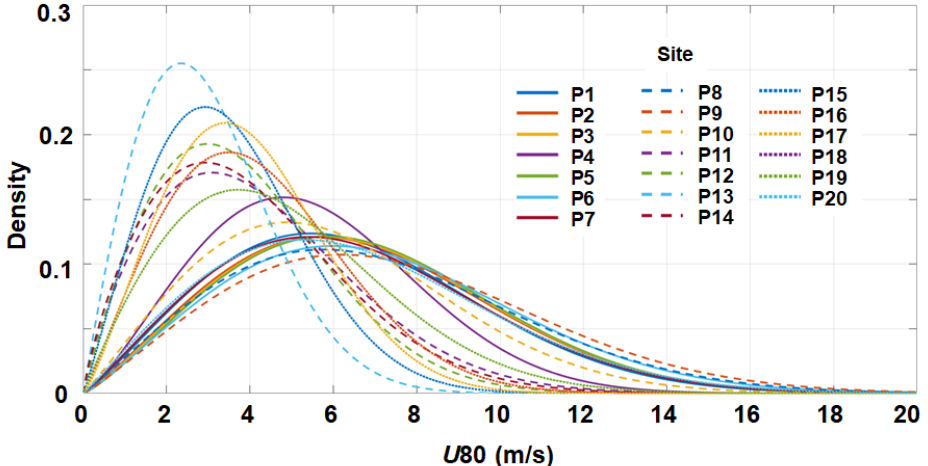
Figure 5. The Weibull distributions corresponding to the ERA-Interim values (January 1998– December 2017).